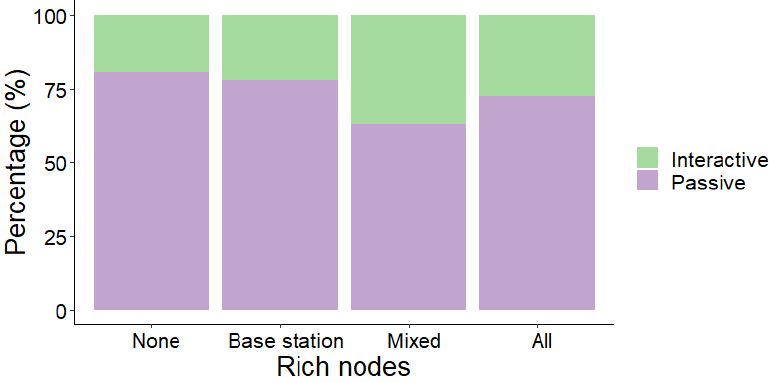
Figure 19. Deployment distribution between usage of rich nodes and node mobility.